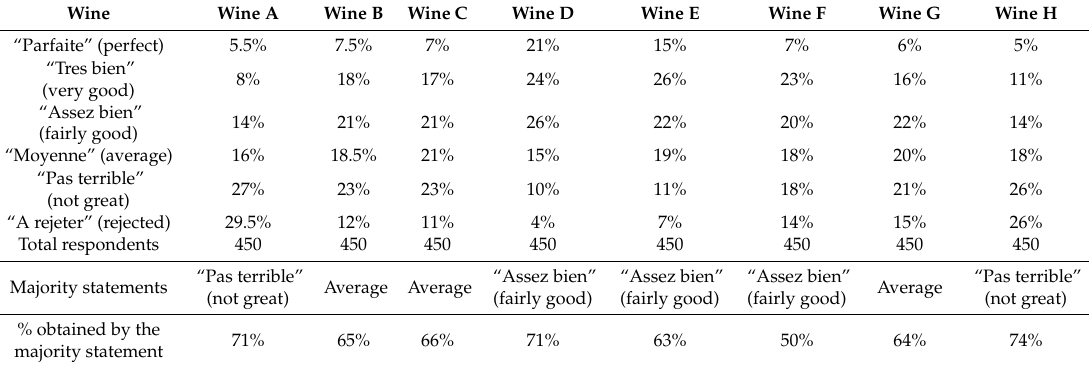
Table 3. Results of the survey on the assessment of the colours of rose